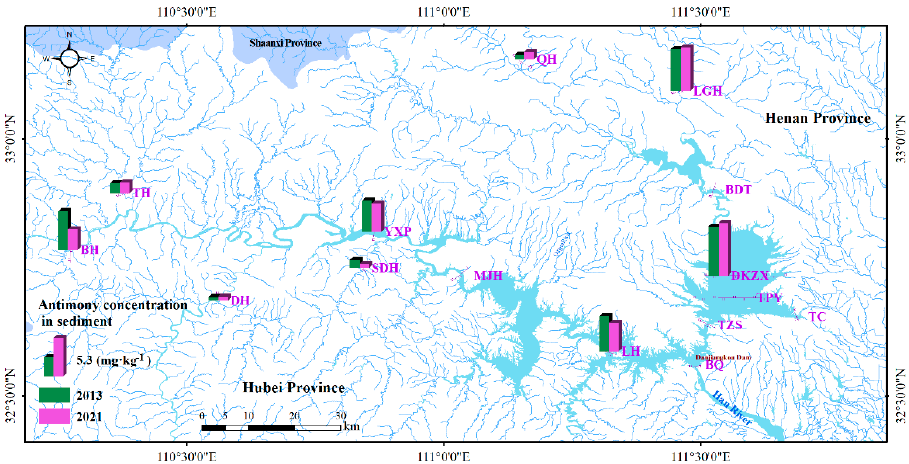
Figure 3. Distribution of antimony contents in Danjiangkou Reservoir sediments.